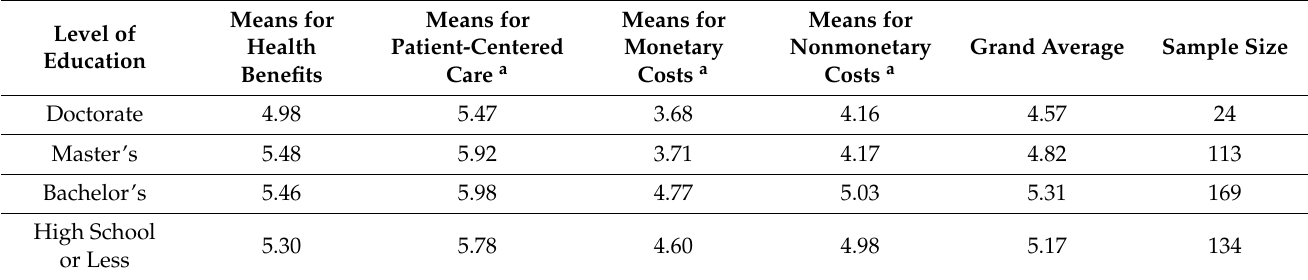
Table 6. Means for Dimensions of Patient Satisfaction by Patient Education